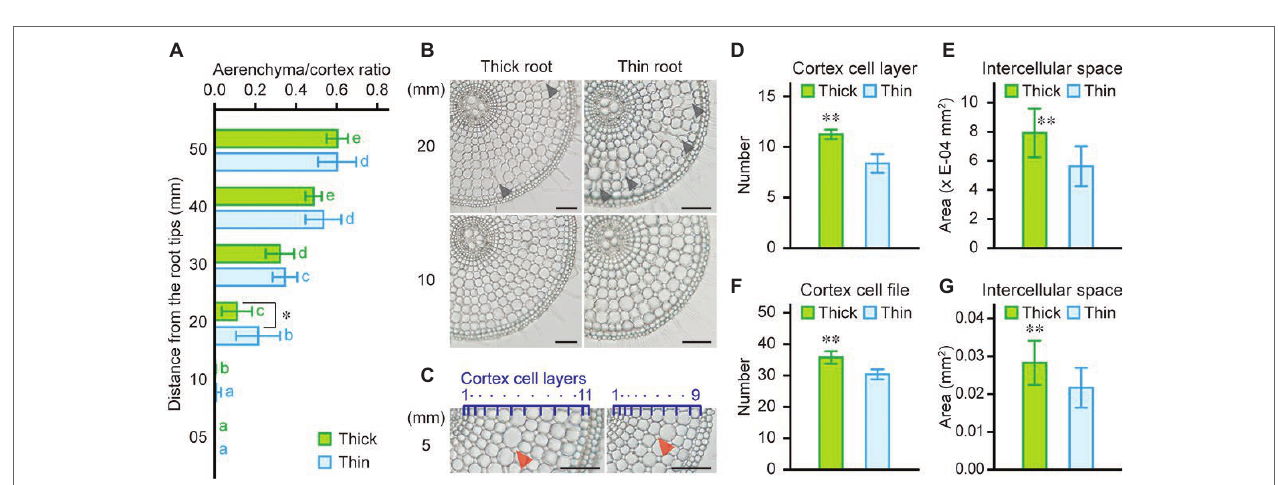
FIGURE 6 | Intercellular spaces of thick and thin adventitious roots of rice. (A) Ratio of aerenchyma to cortex at 5, 10, 20, 30, 40, and 50 mm from the tips of thick and thin adventitious roots of rice under stagnant conditions. (B) Cross-sections at 10 and 20 mm from the tips of thick and thin adventitious roots under stagnant conditions. Lysigenous aerenchyma is indicated by black arrowheads. Bars = 100 μ m. (C) Cross-sections at 5 mm from the tips of thick and thin adventitious roots under stagnant conditions. Cortex cell layers are indicated by dark blue numbers and dots. Intercellular spaces are indicated by red arrowheads. Bars = 100 μ m.